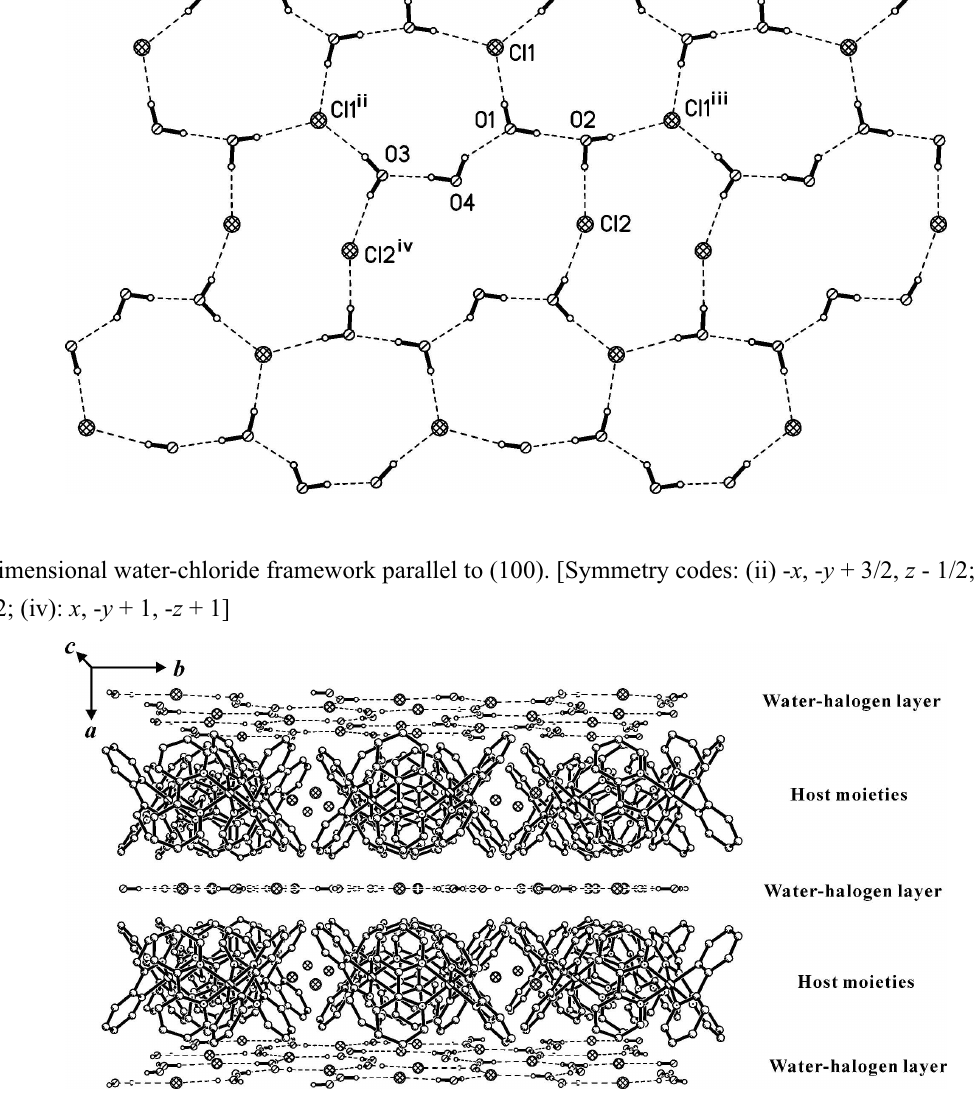
Figure 4 Packing diagram of the supramolecular edifice viewed along the crystallographic c